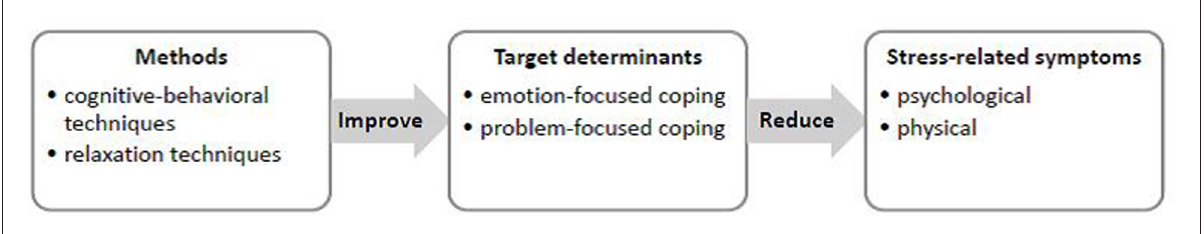
Figure 1: Logical model of the present study: It is assumed that practicing cognitive-behavioural techniques and relaxa- tion exercises should improve emotion-focused as well as problem-focused coping skills, which in turn should reduce physical as well psychological stress-related